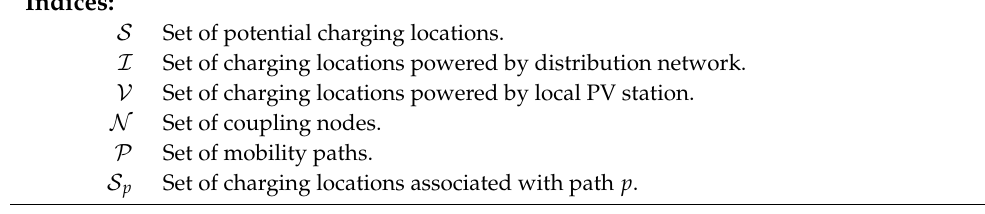
Table 3. Notations and